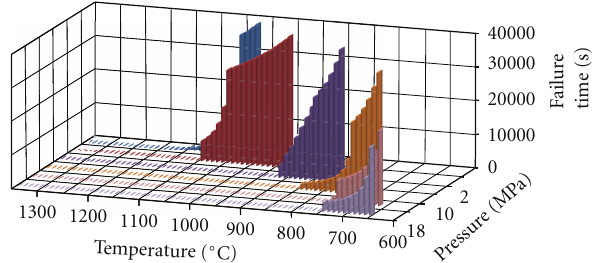
Figure 7: Failure time diagram for a RCL of 20 MnMoNi 55.